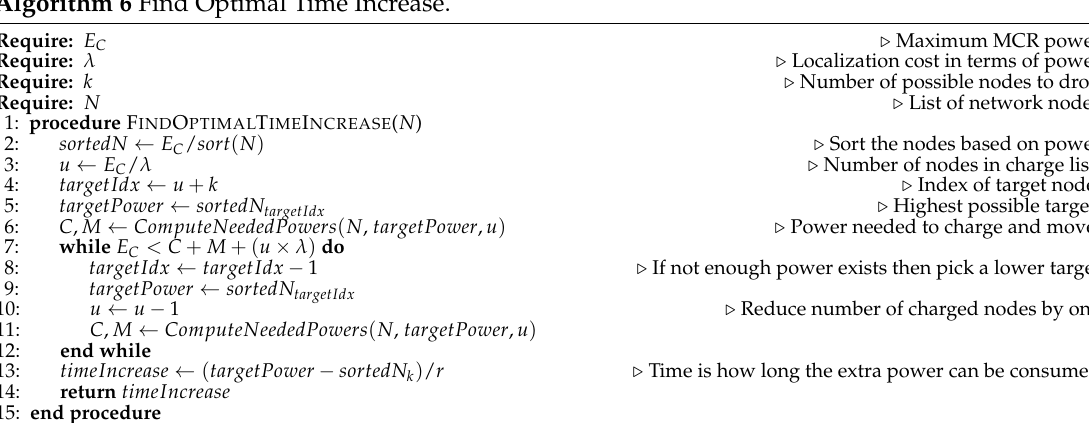
Algorithm 6 Find Optimal Time